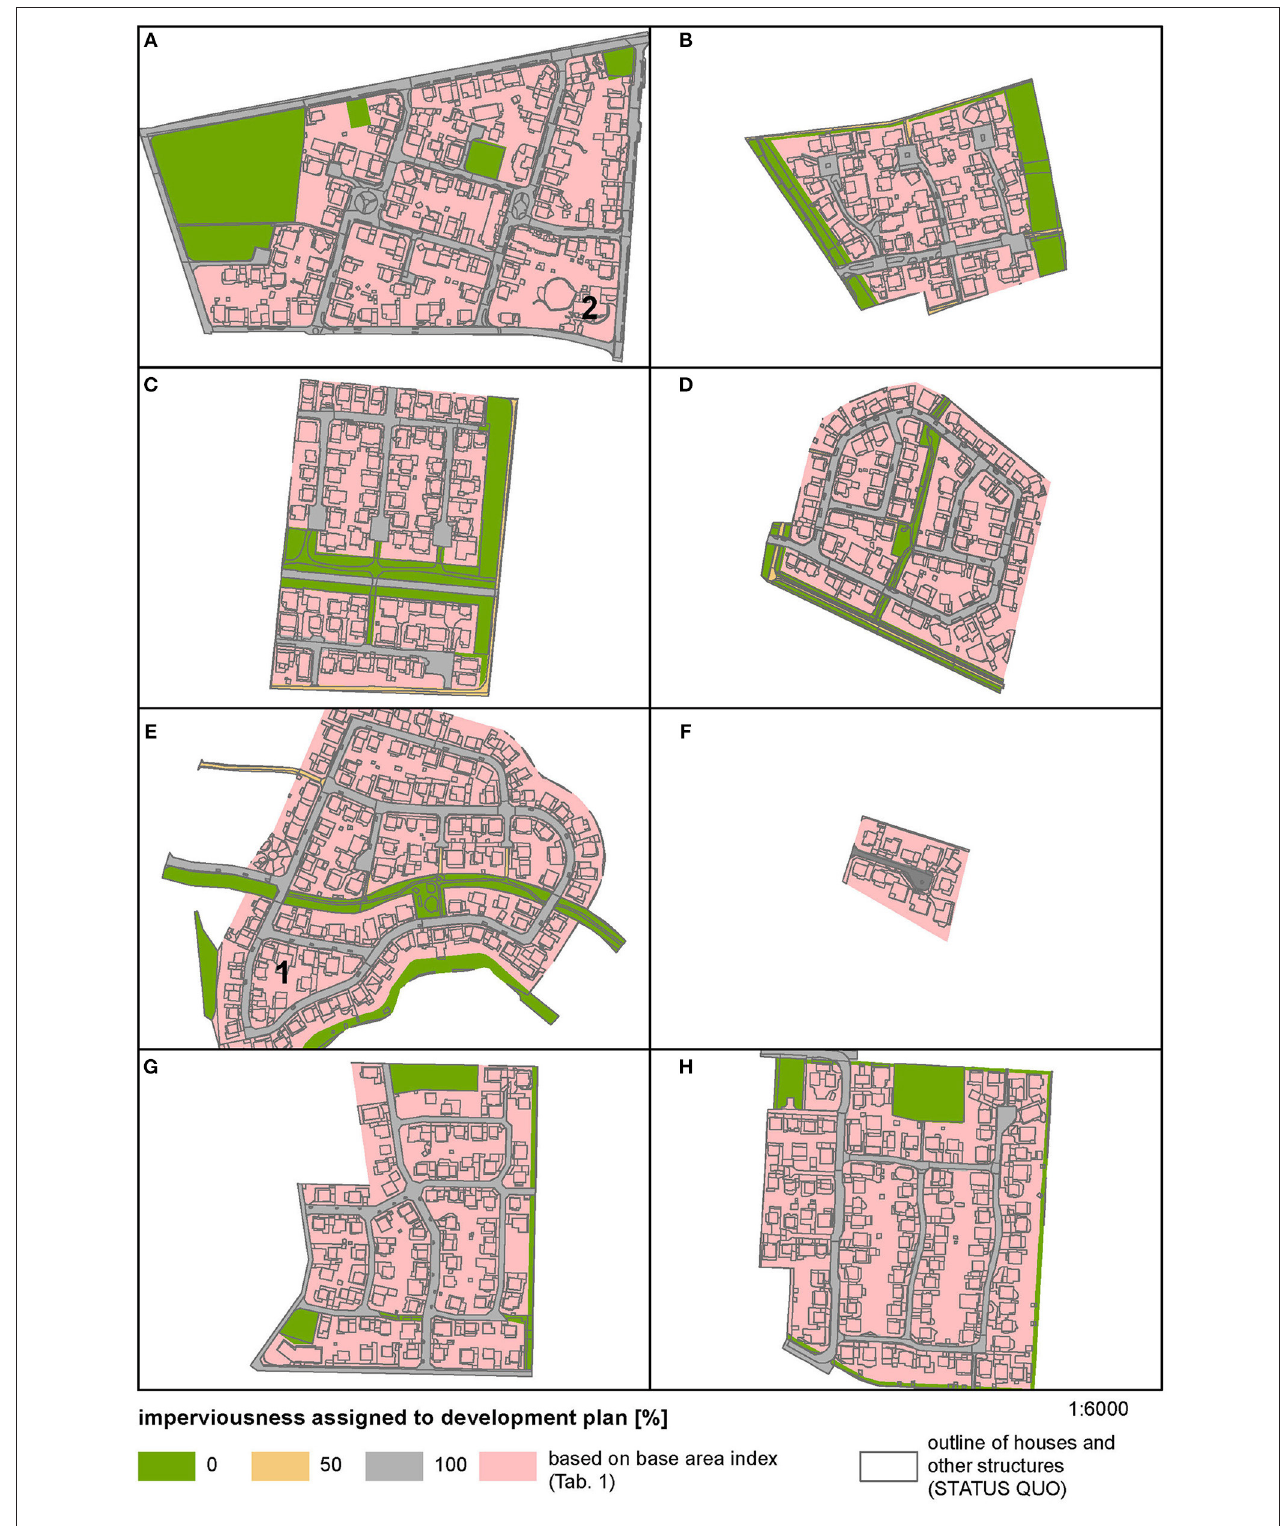
FIGURE 2 | The housing development plans with the assigned imperviousness. The status quo of built structures (houses, garages, driveways) are shown as light gray lines. For more information on the sites, refer to Table 1 . The number 1 in development plan E refers to a section with higher base area (c.f. Table 1 ). Number 2 in the development plan A refers to an area of public use where no base area was given. Therefore, the base area was assumed to be equal to the rest of the area.